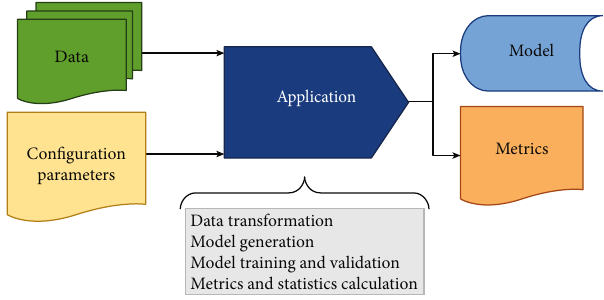
Figure 6: Model generation tool